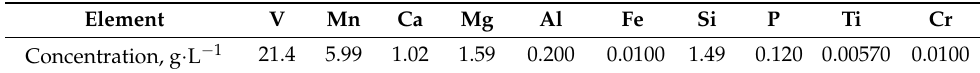
Table 1. Main composition of the acidic vanadium-bearing solution. Element V Mn Ca